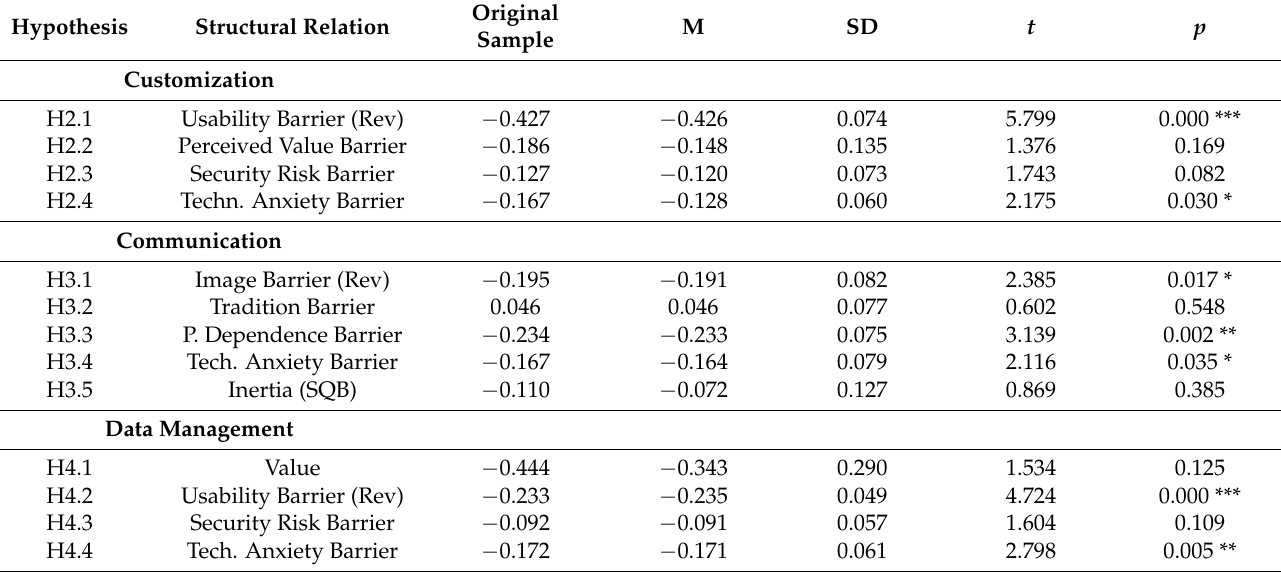
Table 4. Results from the H2, H3, and H4 sets about effect on adoption